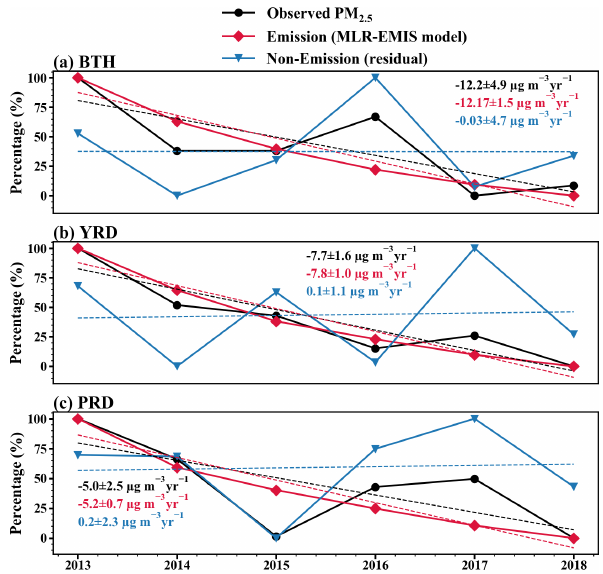
Figure 2. Results of MLR-EMIS analysis for 2013–2018 in BTH (a) , YRD (b) , and PRD (c) . Temporal variations in observed winter PM 2 . 5 concentration are shown in black; contributions of an- thropogenic emissions to the PM 2 . 5 trend are shown in red; and the residual is shown in blue. Values inset in each panel are the ordinary linear regression trends, with 95% confidence intervals obtained by Student’s t